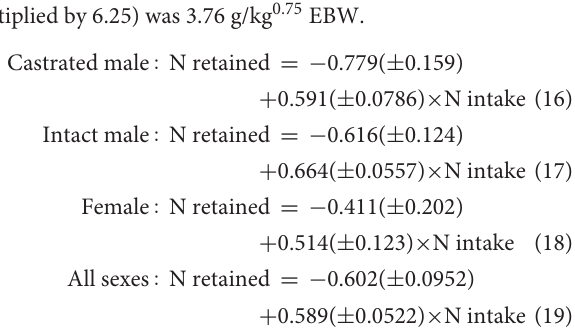
BW (at N intake = 0), which corresponds to a NP M of 3.18 g/kg 0.75